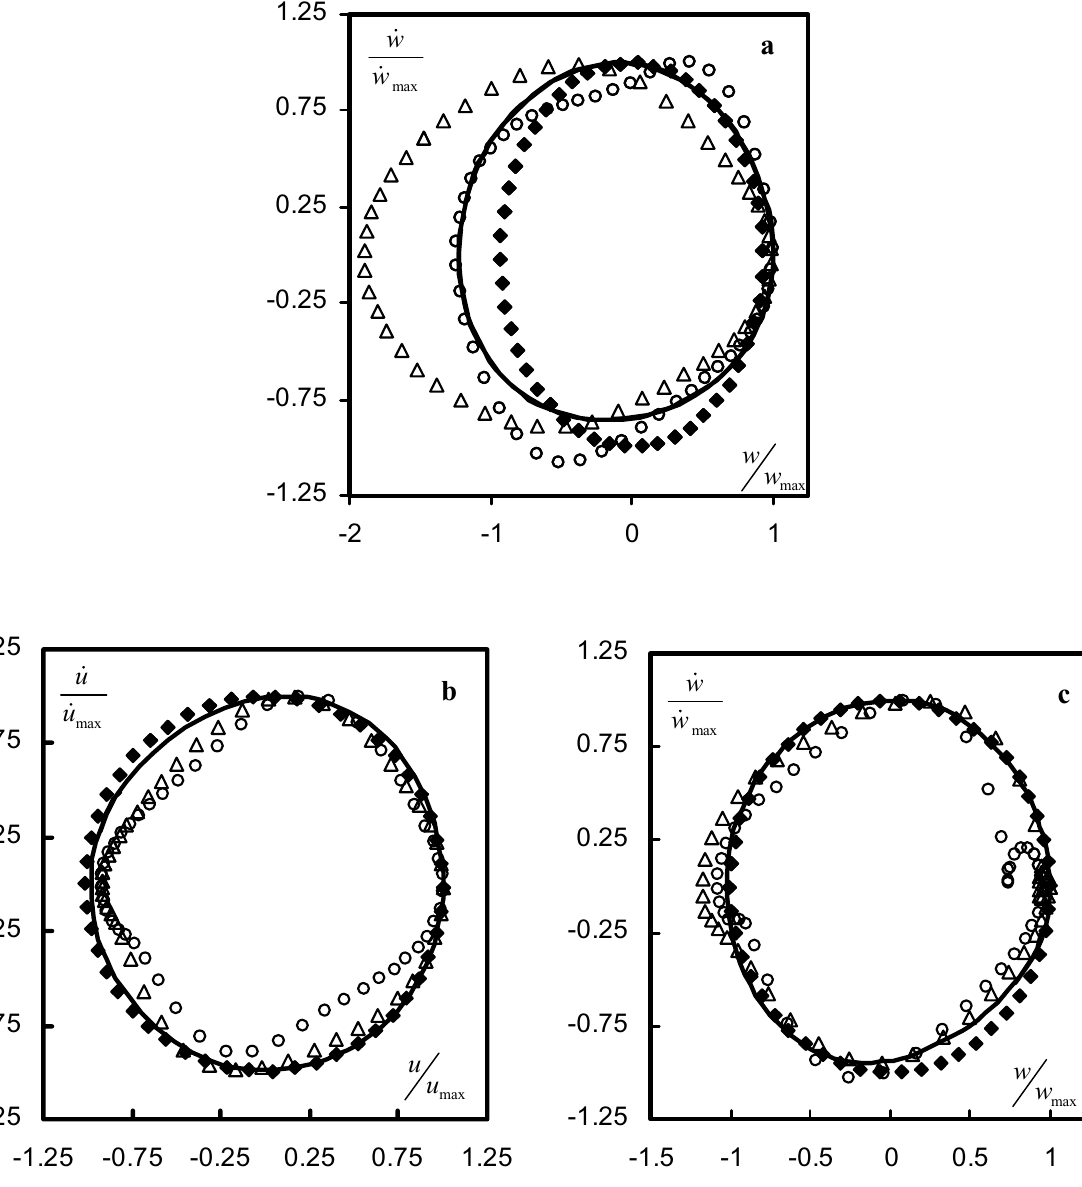
Fig. 9. Phase plots of oscillations of Shells (cid:2) h/a = 0.05, — h/a = 0.01, ∆ /a = 0.005, o h/a = 0.001, at the following points and directions: (a) Point 2, direction z ; (b) Point 1, direction x ; (c) Point 1, direction z . h/a = 0.05, h/a = 0.01 and h/a = 0.005, the amplitude of excitation is 2500 h /0.03 N, i. e., the amplitude of